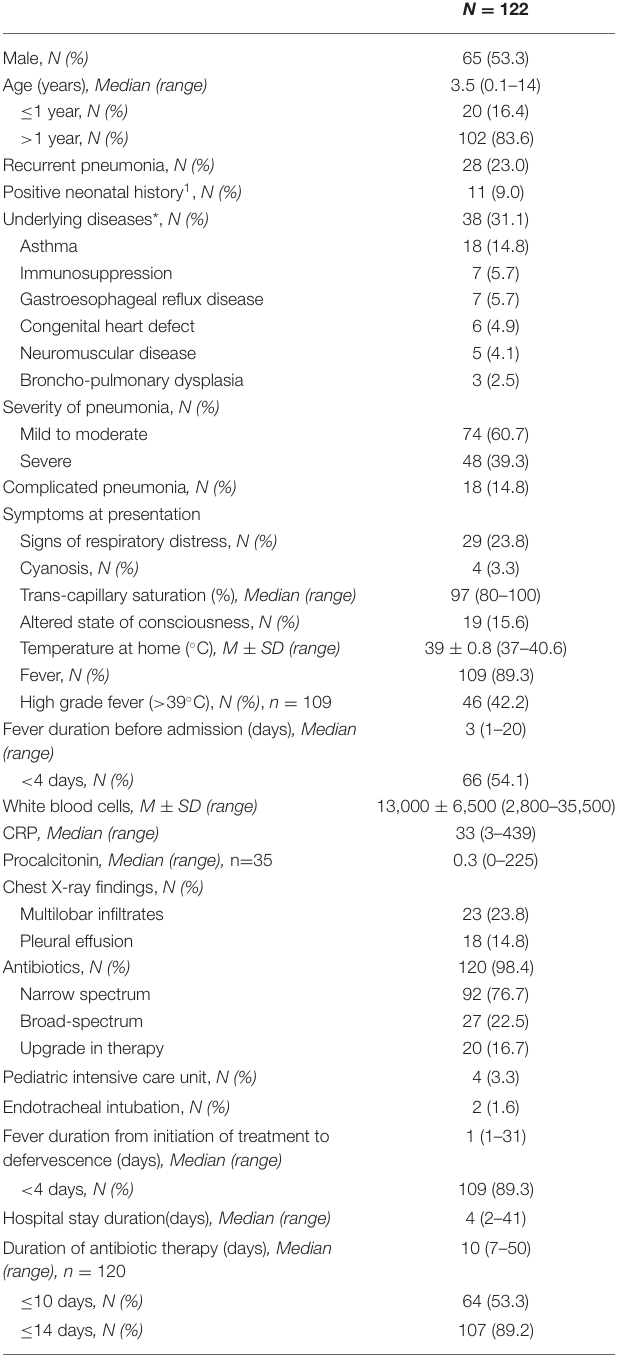
TABLE 1 | Patients